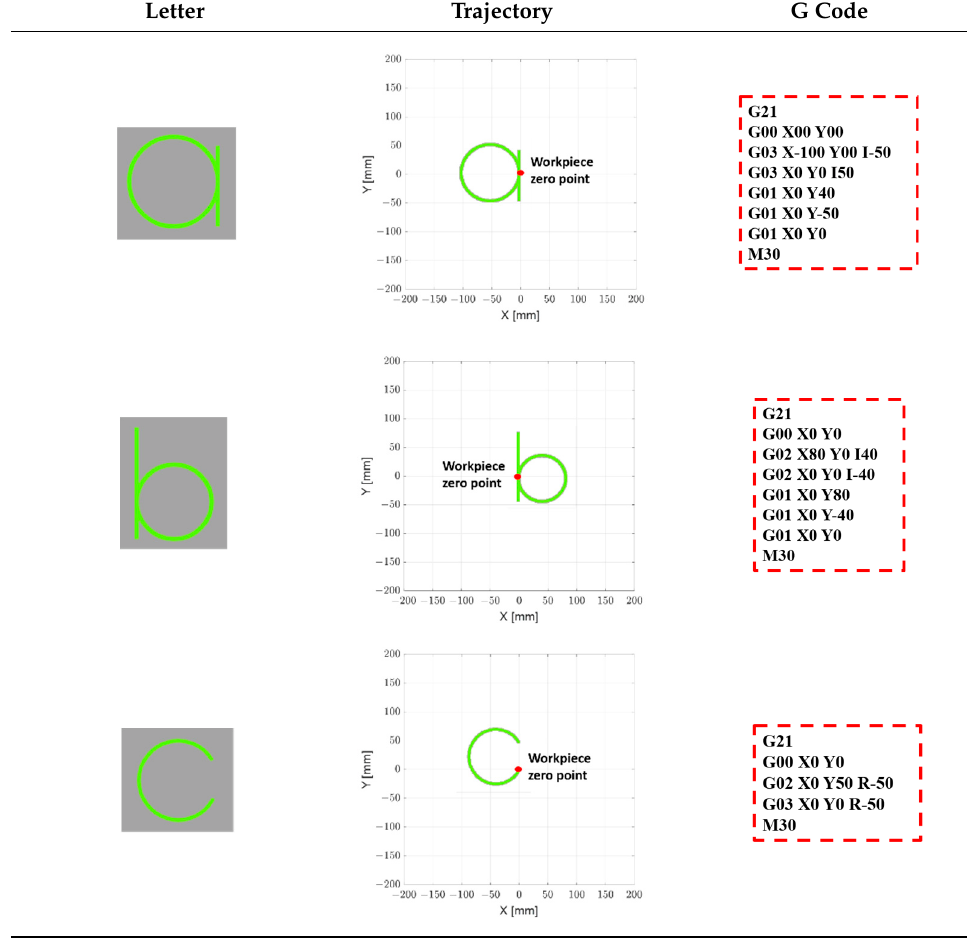
Table 7. G code for rehabilitation movements.